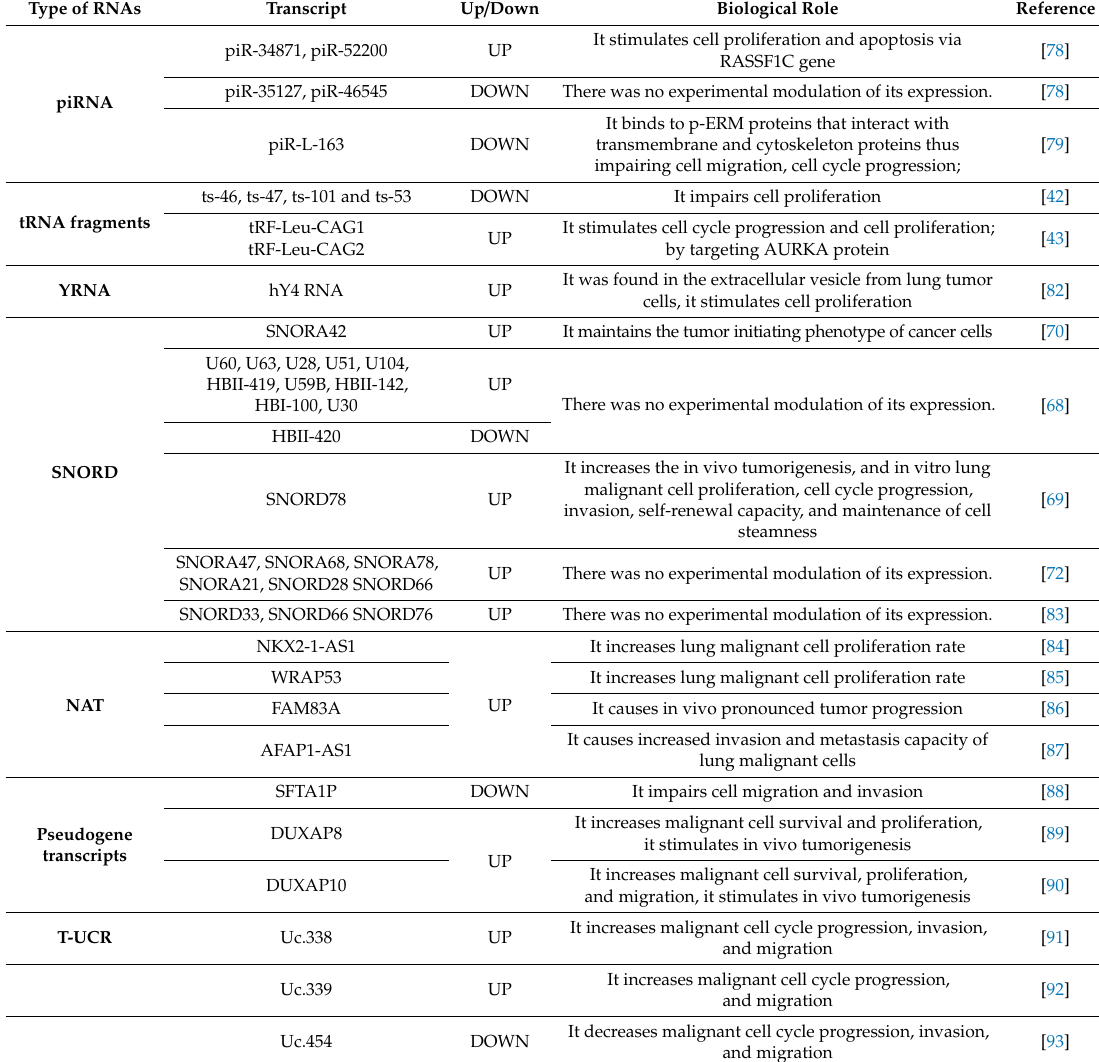
Table 3. Some example of altered ncRNAs involved in lung